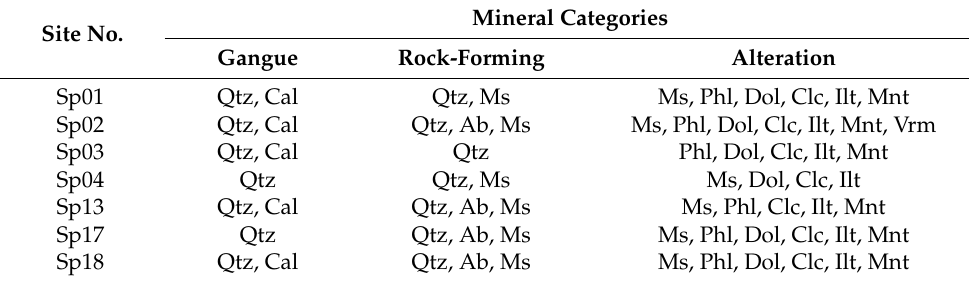
Table 2. Mineral composition of the tailing samples derived from XRD analysis. Site